Question: Write a single sentence explaining what this figure depicts.
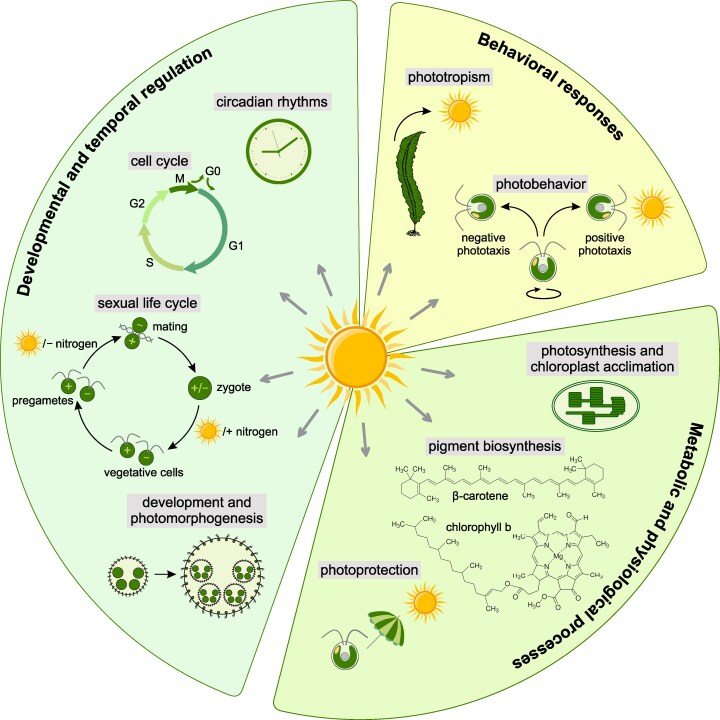
Answer: Light-dependent physiological, behavioral, and developmental processes in algae. Conceptual overview of major light-regulated processes documented across algal systems, organized into 3 functional domains: metabolic and physiological processes, behavioral responses, and developmental and temporal regulation. These include photosynthesis and chloroplast acclimation, photoprotection, pigment biosynthesis, photobehavior, including phototaxis and phototropism, circadian regulation, control of the cell cycle, developmental programs and photomorphogenesis, and transitions of the sexual life cycle. Arrows radiating from the central light source illustrate how light acts as a common regulatory input across these processes. Redrawn and modified after Petersen et al. (2021) , with additional elements added.